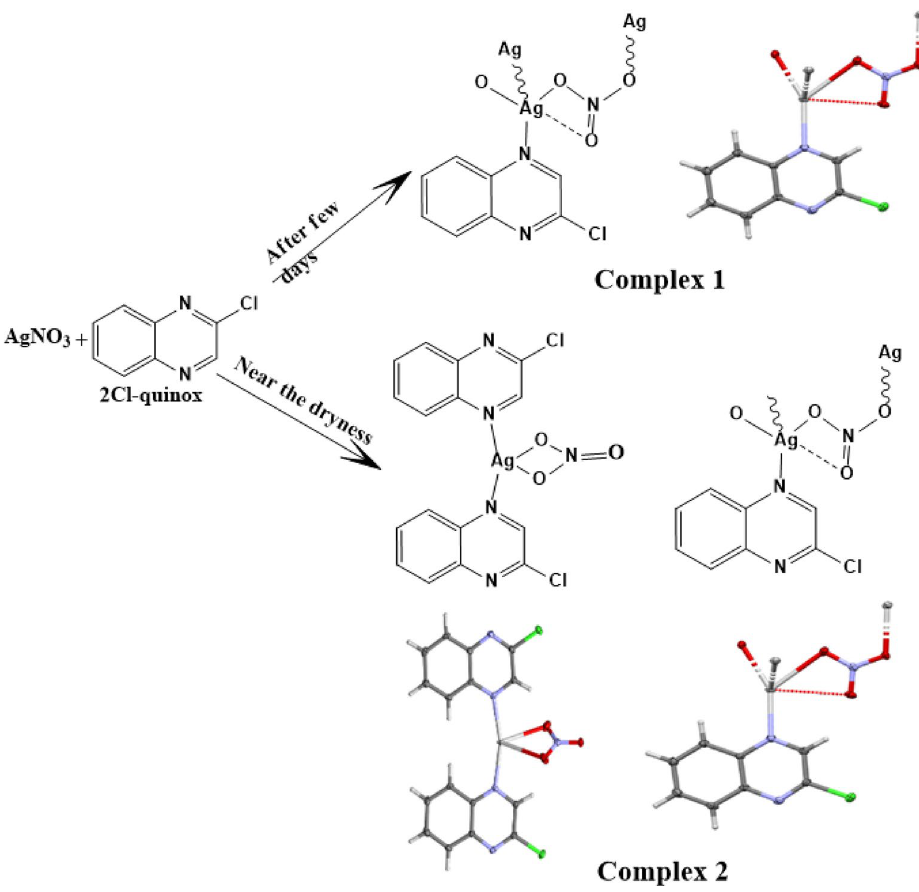
Figure 2. Scheme of the Synthesis of complexes 1 and 2 .